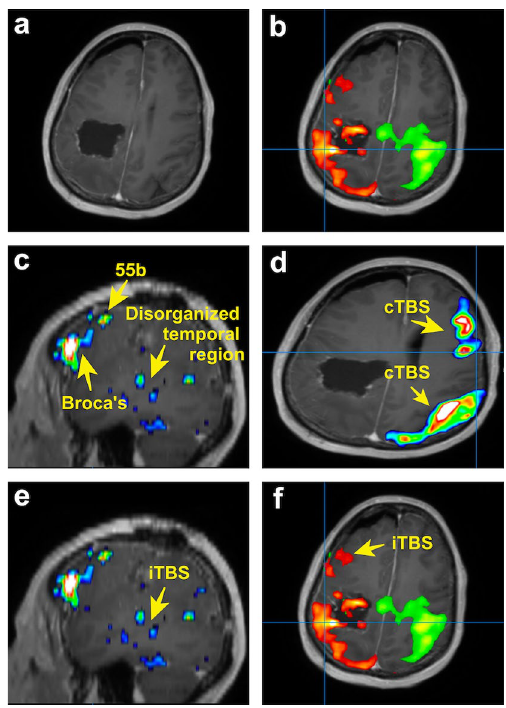
Figure 5. TMS strategy for patient presenting with aphasia and near complete hemiplegia secondary to glioblastoma. ( a ) Postoperative MRI of patient demonstrating resection cavity. ( b ) Independent right sided (green) and left sided (orange) sensorimotor networks. Although presented on the same image, these networks appeared as separate networks on connectomic analysis. The anterior satellite areas in the left (orange) dysfunctional sensorimotor network. ( c ) Left frontoparietal network demonstrating clear Broca’s area and area 55b. The temporal component of the network is disorganized. ( d ) cTBS was administered to both the middle of the sensorimotor network and the right posterior frontal component of the right frontoparietal network. ( e ) iTBS was administered to the disorganized temporal component of the left frontoparietal network and the ( f ) anterior areas of the pathological left sensorimotor